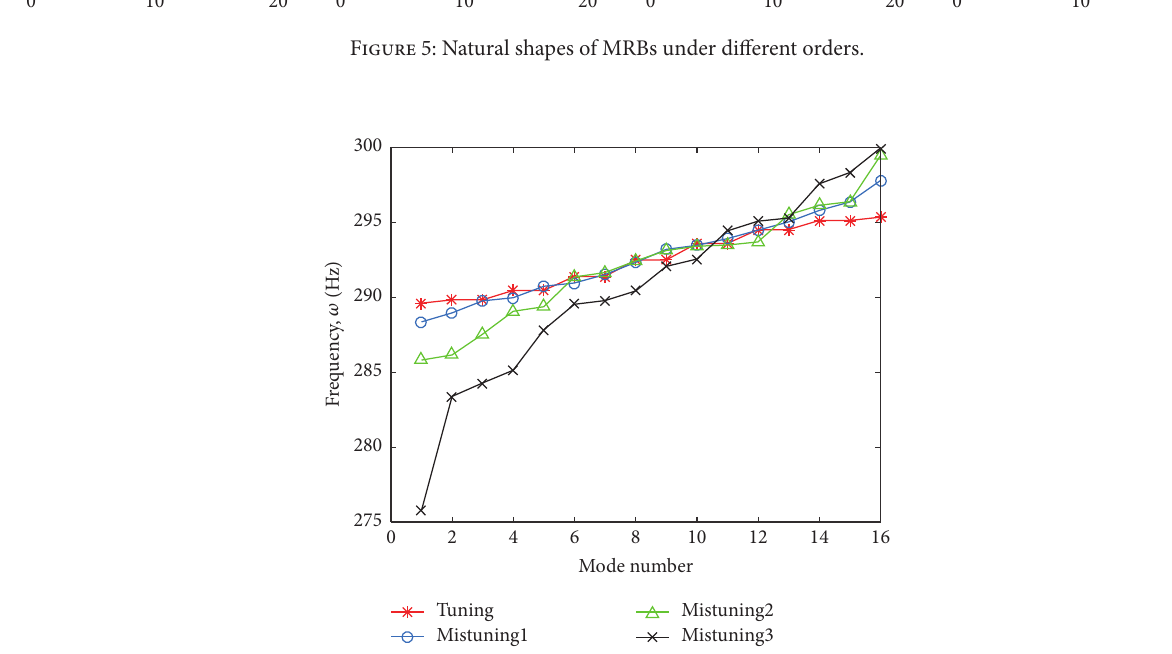
Figure 6: Natural frequencies of MRBs under different mistuned